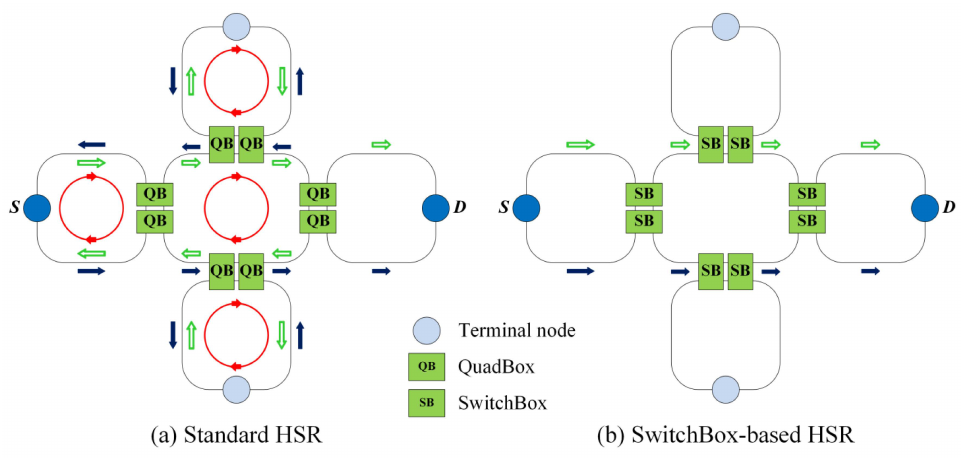
Figure 6. Forwarding a frame from node S to node D